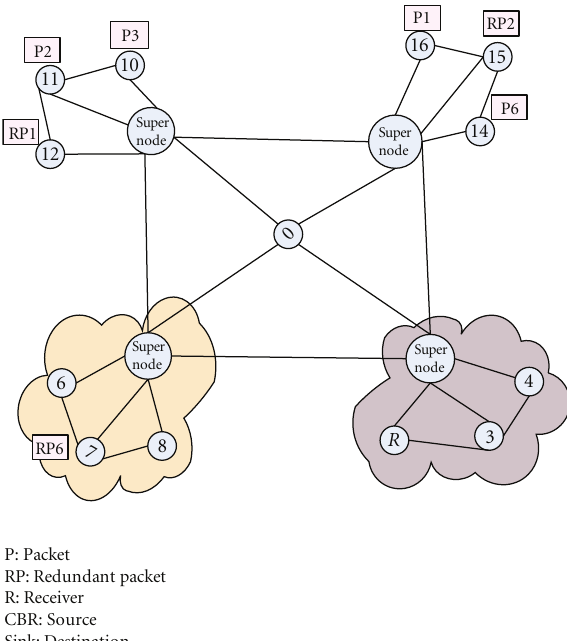
Figure 2: Simulation